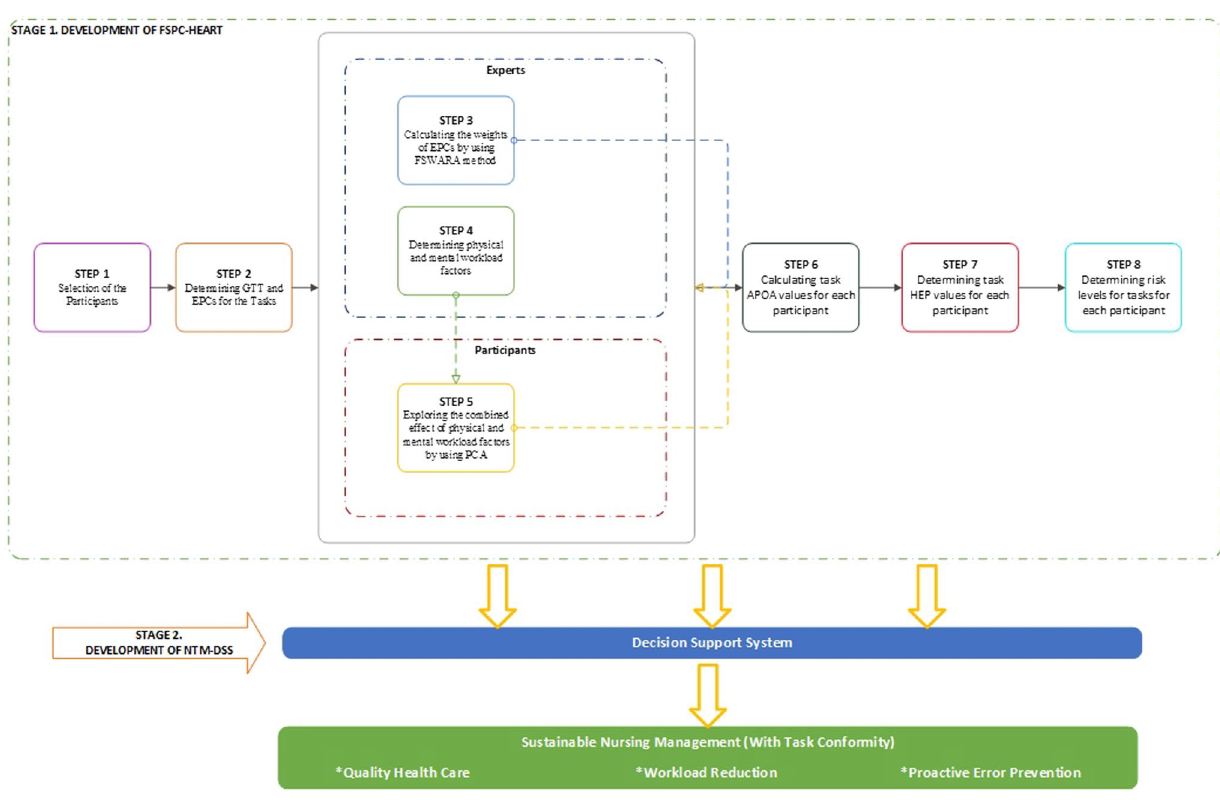
Fig. 3 Stages of NTM-DSS-based FSPC-HEART